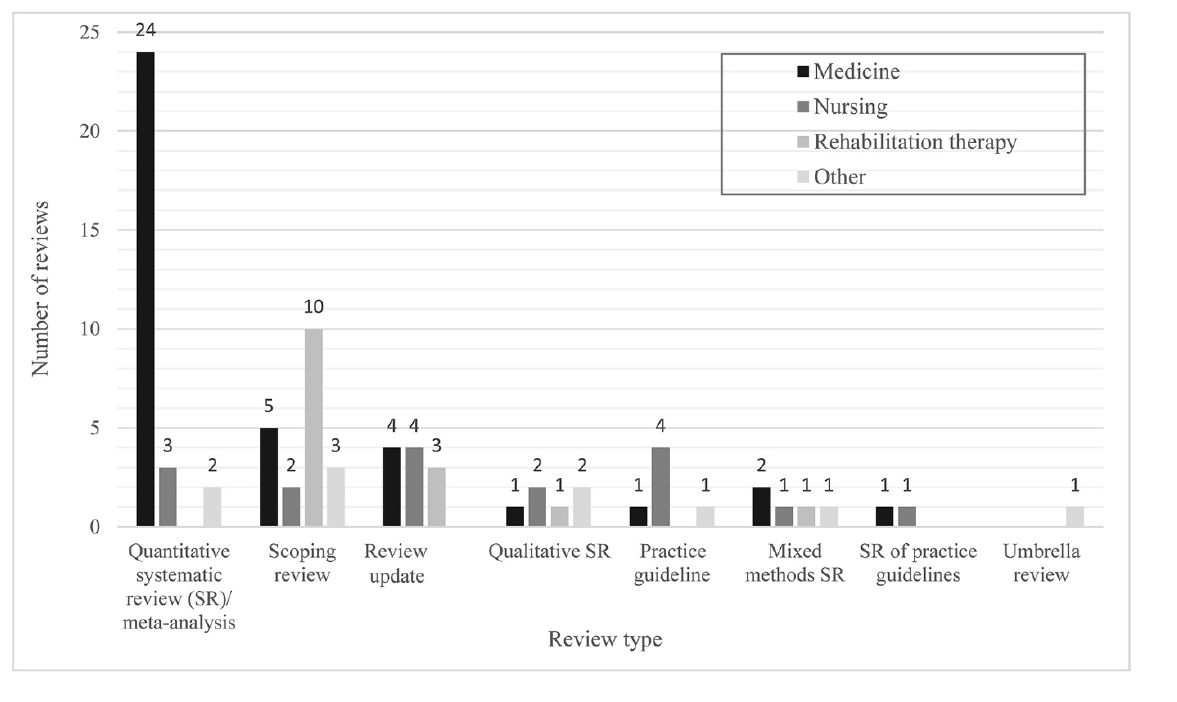
Figure 1 Librarian research review collaborations in 2017/18 by requester